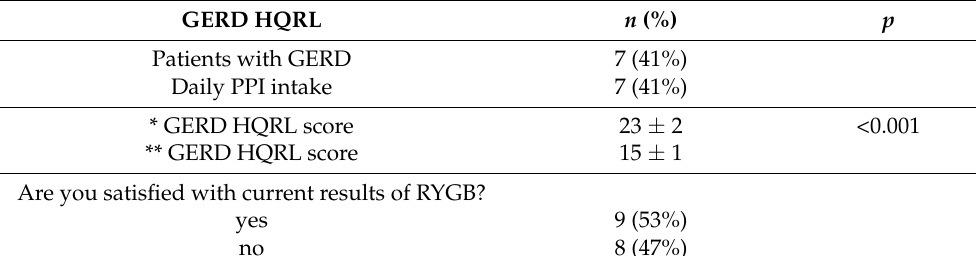
Table 3. Prevalence of Gastroesophageal Reflux, GERD HQRL Quality of Life Questionnaire. GERD HQRL n (%) p Patients with GERD 7 (41%) Daily PPI intake 7 (41%) * GERD HQRL score 23 ± 2 <0.001 ** GERD HQRL score 15 ± 1 Are you satisfied with current results of RYGB? yes 9 (53%) no 8